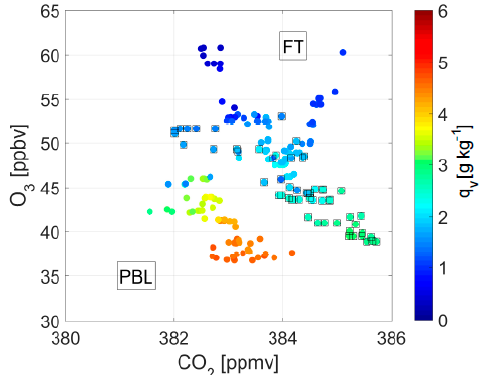
Figure 3. scatter diagram of O 3 and CO 2 11:42UTC [47]. Figure 3. Scatter diagram of O 3 and CO 2 11:42UTC